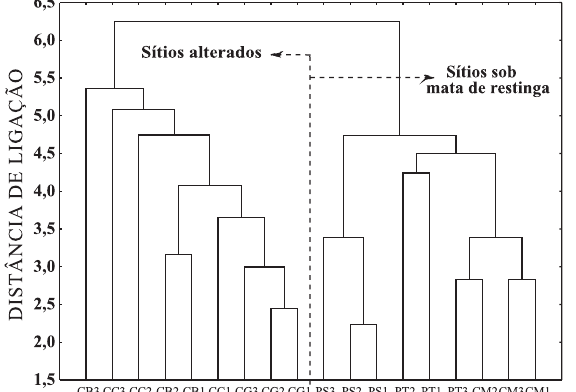
Figura 6. Diagrama de Cluster de 18 sítios de restinga (seis grupos de área e uso da terra com três repetições) a partir da frequência de ocorrência de espécies de formigas (71) amostradas nesses sítios. A figura aponta o isolamento dos sítios de mata relativamente aos sítios alterados. Áreas - CM: Caju, mata; CG: Caju, capim-gengibre; CB: Caju, coqueiral do banco de germoplasma; CC: Caju, capoeira; PT: Pirambu, mata de topo; e PS: Pirambu, mata de